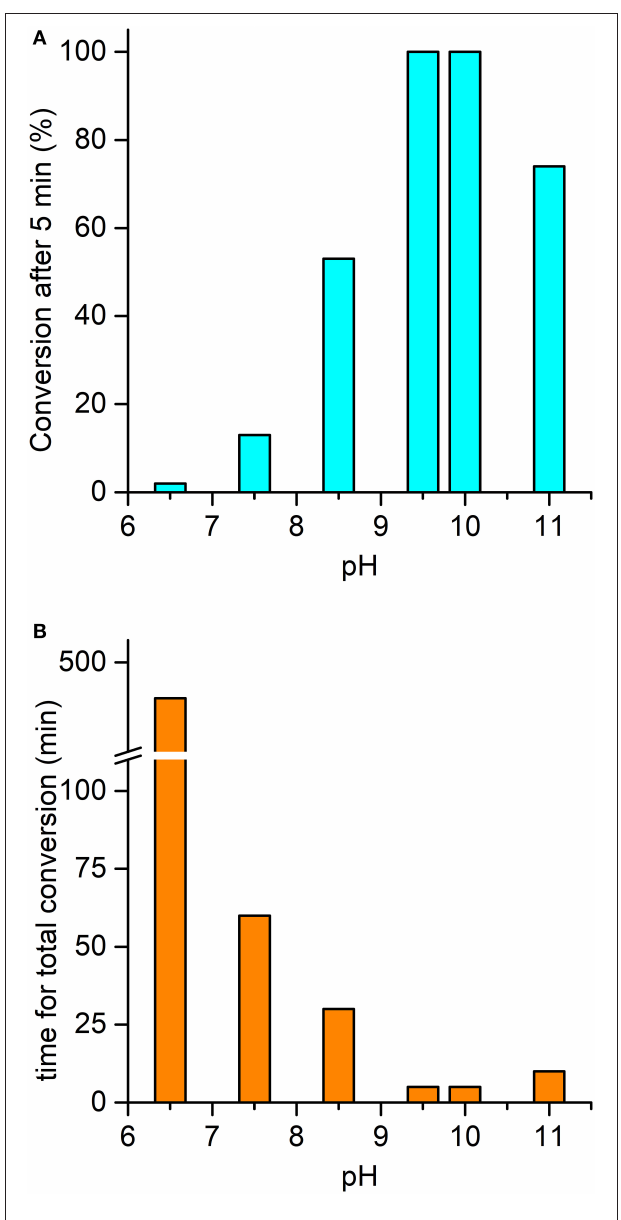
FIGURE 7 | pH-dependent oxidation of thioanisole catalyzed by Mn-MC6*a. (A) Substrate conversion observed after 5min of reaction progress; (B) time required for a complete conversion of the substrate. Reaction conditions : Mn-MC6*a, 20 µ M; H 2 O 2 , 2.0mM; thioanisole 2.0mM; different buffers were used depending on the pH value, as described in the experimental section. At pH 11, a second addition of H 2 O 2 (after the first 5min of reaction time) was needed to reach complete conversion (see text). Substrate consumption was monitored by GC-MS analysis of the reaction mixture, using anisole as internal